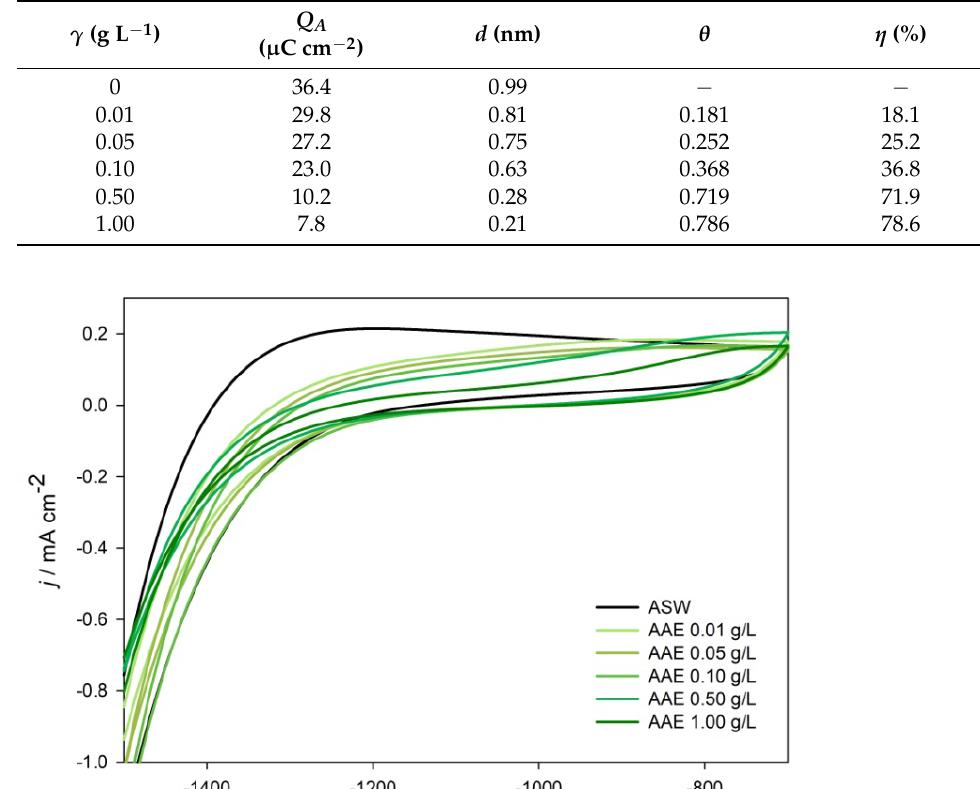
Table 2. Anodic charges, film thickness, surface coverage, and inhibition efficiency for the Al 5083 alloy in ASW without and with the addition of different concentration of Artemisia annua L. extract (AAE).